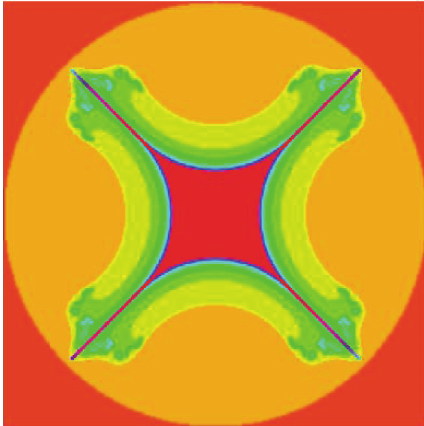
Figure 10: Relative superior multicorn for 𝑠 = 0.6 and 𝑠 󸀠 = 0.5 .